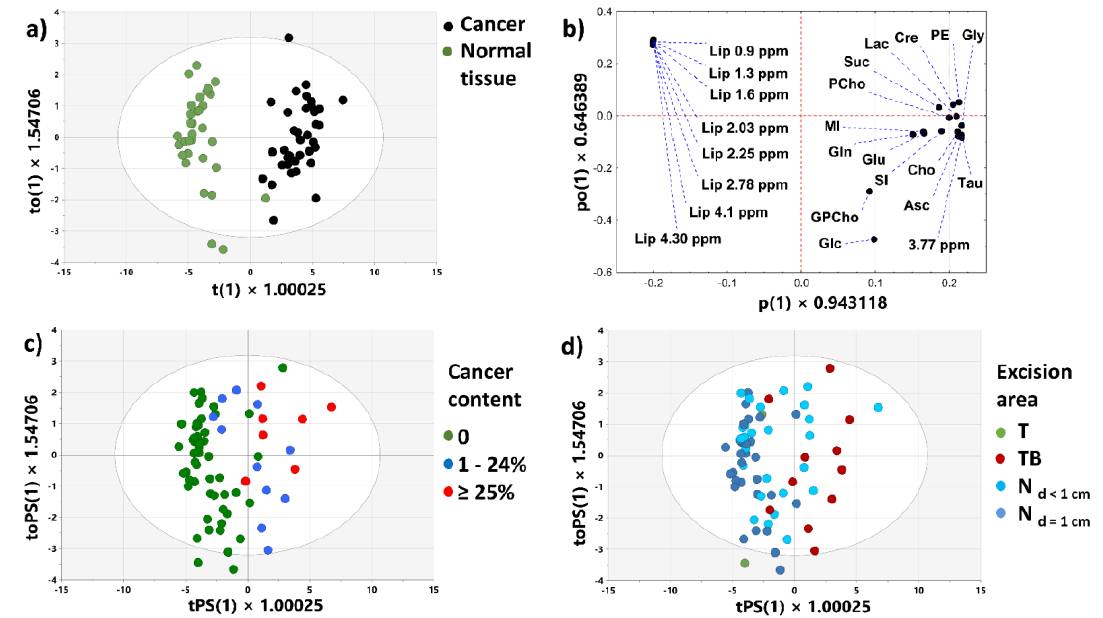
Figure 6. The OPLS-DA model 1: the scores plot ( a ), the loadings plot ( b ), the predicted scores plot colored according to the cancer content ( c ), the predicted scores plot colored according to the excision area ( d ). Scores and loadings for the predictive component are denoted as t(1) and p(1), whereas those for the orthogonal one — as to(1) and po(1). The predicted scores for the predictive component are denoted as tPS(1), whereas those for the orthogonal one — as toPS(1).